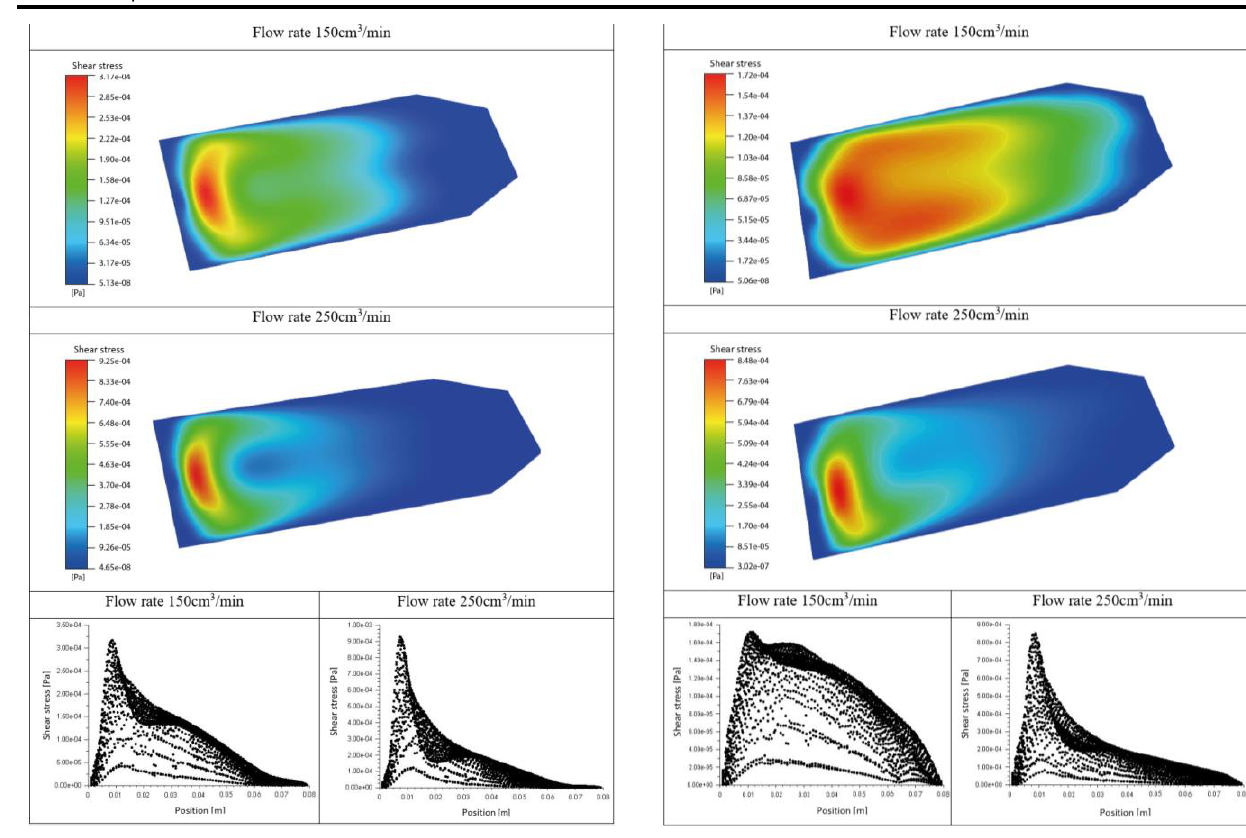
Fig. 8. Maps and diagrams of shear stress distribution on the lower wall of the sampler for model 4